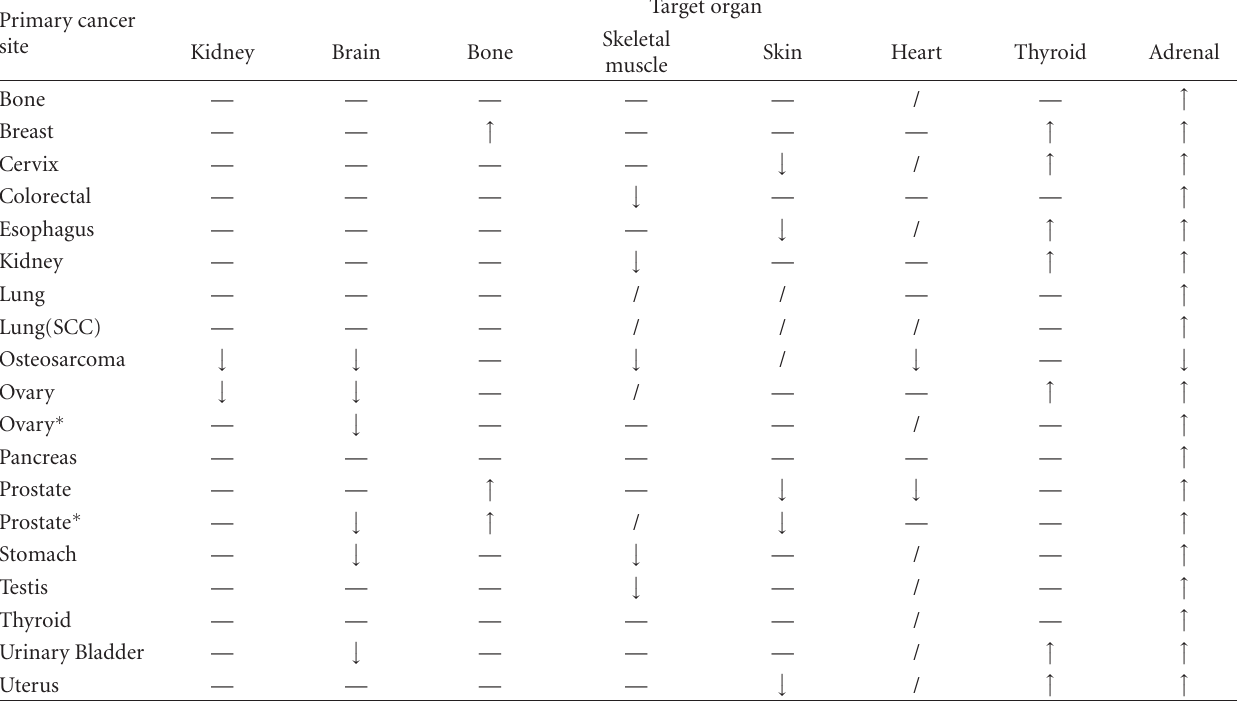
Table 1: Interactions between primary cancer site and target organ based on metastatic e ffi ciency indexes. Primary cancer